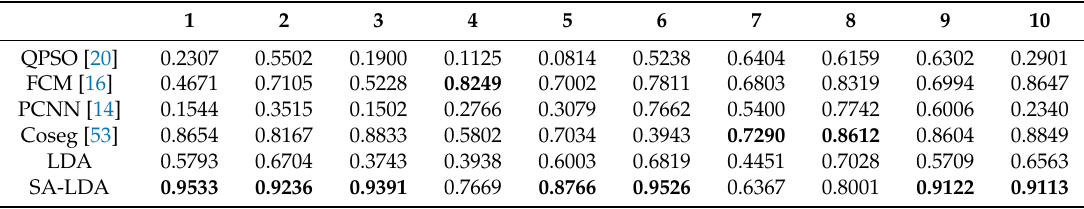
Table 1. Image segmenting accuracy (IA) of the comparative experiments. The methods below are quantum-behaved particle swarm optimization (QPSO), fuzzy c-means clustering (FCM), pulse coupled neural network-based segmentation (PCNN), co-segmentation, the traditional latent Dirichlet allocation (LDA), and self-adaptive latent Dirichlet allocation